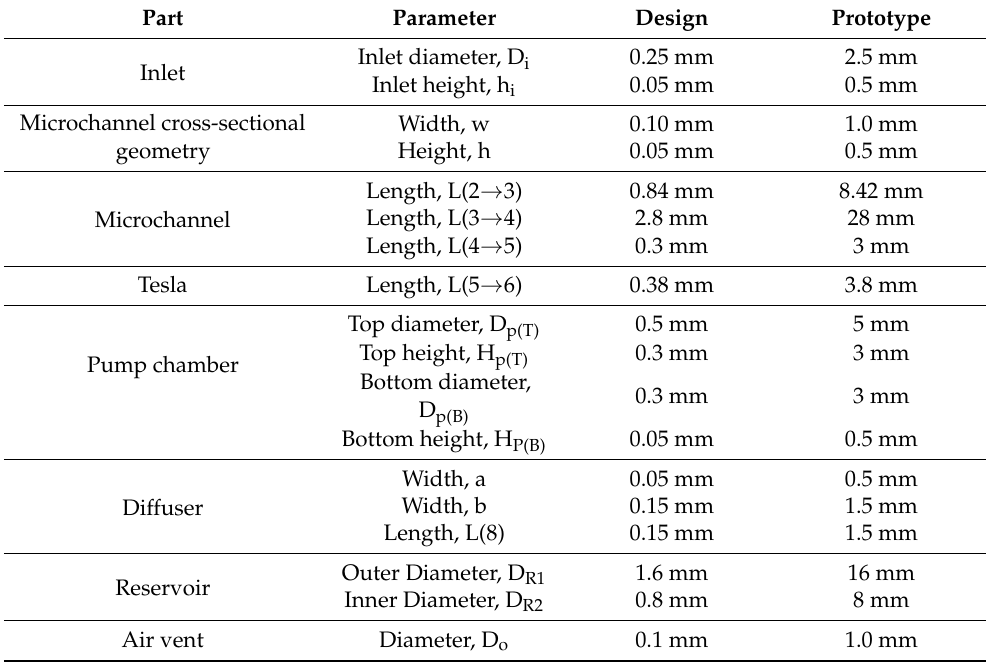
Table 1. Geometry of design and prototype of microfluidic